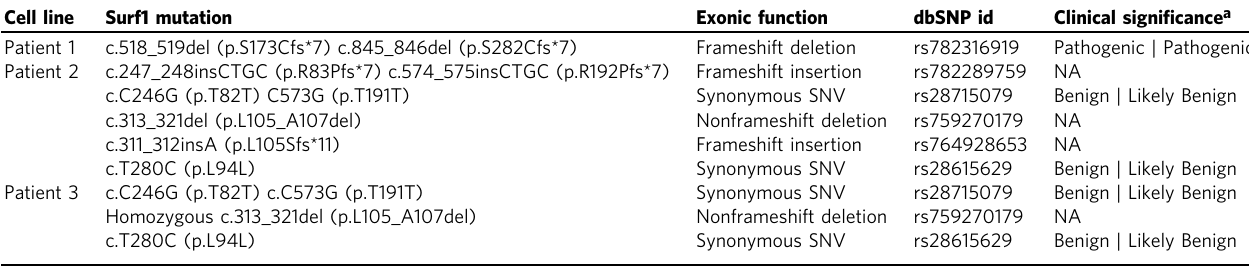
Table 3 Genotyping results of SURF1 patient-derived fi